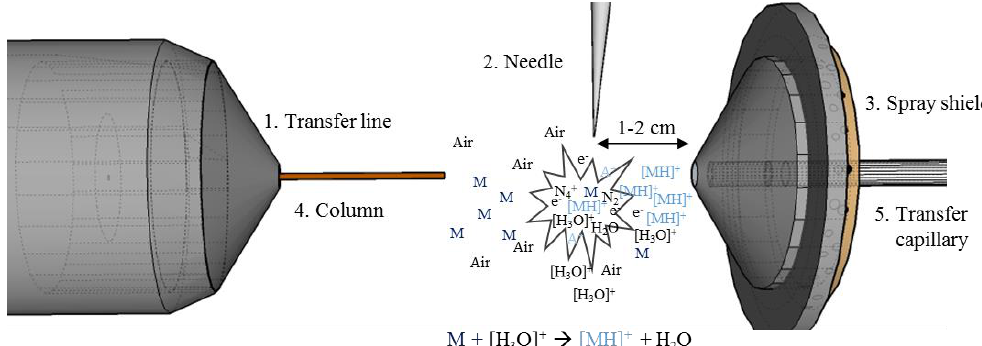
Figure 1. Overview of a conventional gas chromatography-atmospheric pressure chemical ionization-mass spectrometry (GC-APCI-MS) set up. The system contains the transfer line (1), the APCI corona needle (2), spray shield (3), the GC column (4), and a transfer capillary (5). The needle is mounted 1–2 cm from the interface system. Between the needle and the inlet system is the plasma zone, where the reaction cascade take place.